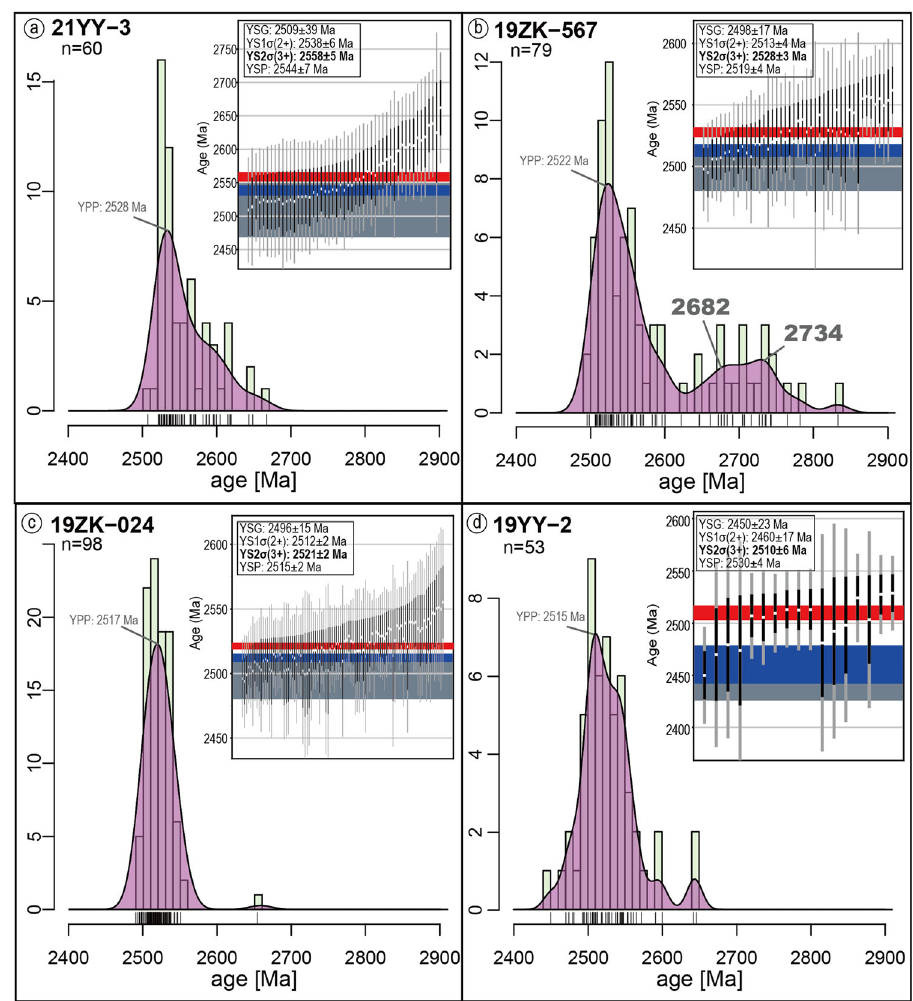
Fig. 8 | Detrital ages spectrum diagram and MDAs. For Abbreviations refer to Fig.2. YPP is labelled in the spectrum, and YSG, YC1 σ , YC2 σ , YSP results are shown intheinset. a 21YY-3,metasandstoneatthebaseofUnit2. b 19ZK-567,greywackeat the top of Unit 2. c 19ZK-024, quartzofeldspathic arenite in Unit 3. d 19YY-2, metapelite at the top of Unit 2, interlayered with carbonate. The inset shows the